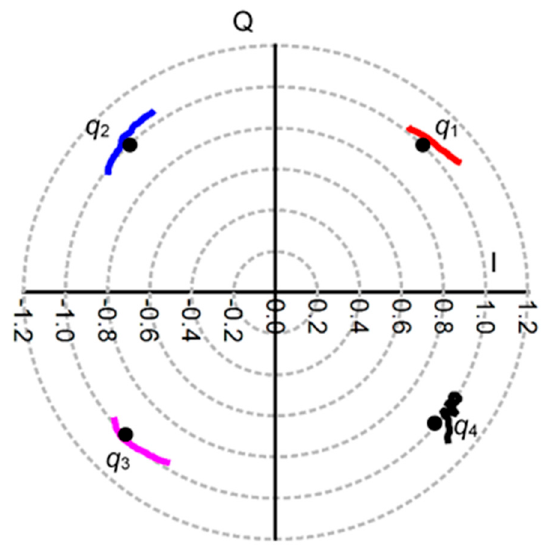
Figure 36. The q i points position of the multi-port over 10 GHz band (80–90 GHz).